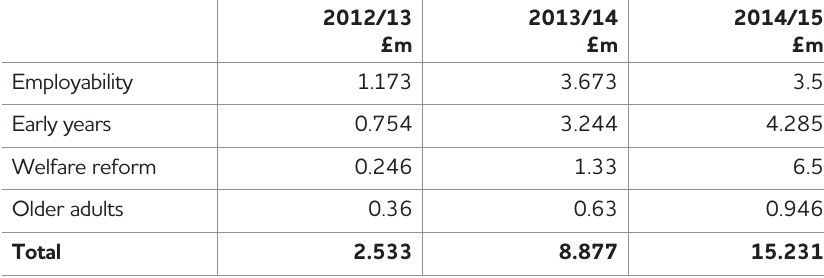
Table 5: Investment expenditure in Renfrewshire by activity, 2012/13 to 2014/15